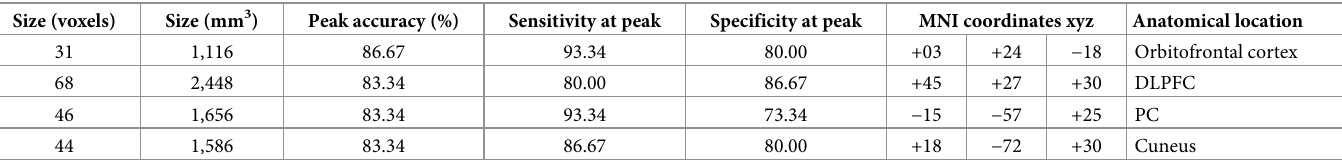
Table 3. Network-level functional classification